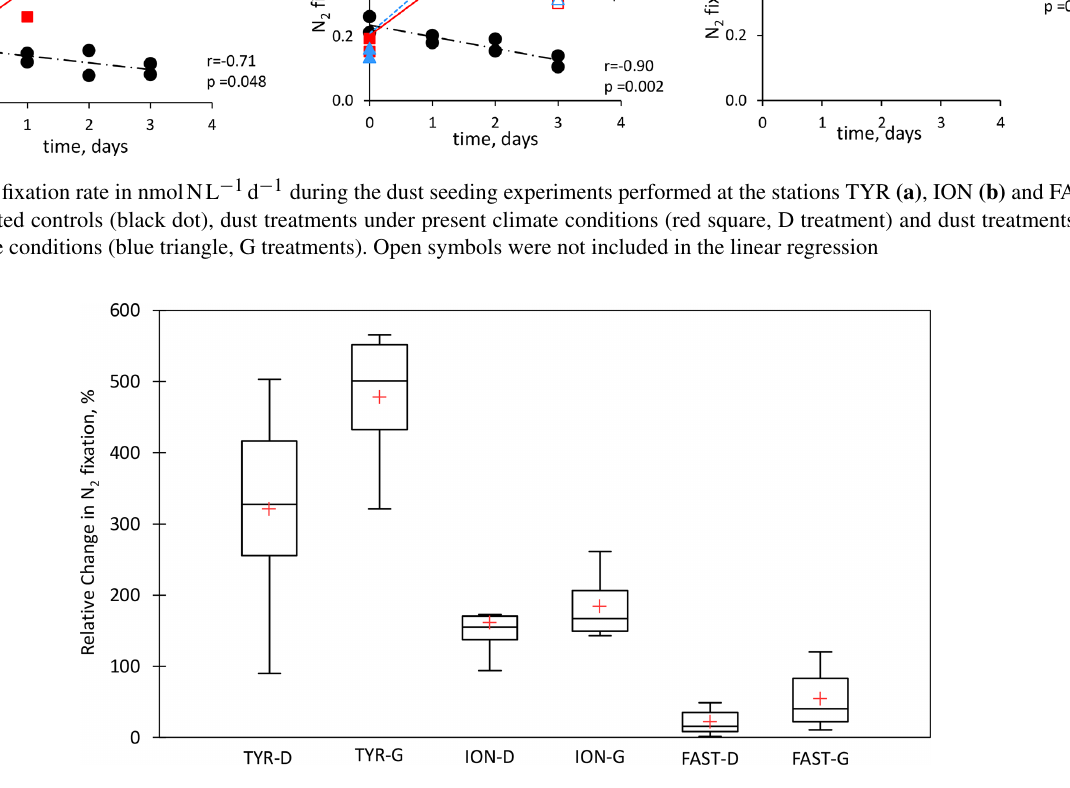
Figure 7. Box plots of the relative changes (in percent) in N 2 fixation to the rates measured in the controls over the duration of the dust seeding experiments (T1, T2, and T3 or T4) at TYR, ION and FAST stations. D means dust treatments under present climate conditions (D treatment) and G dust treatments under future climate conditions (G treatment). The red cross represents the